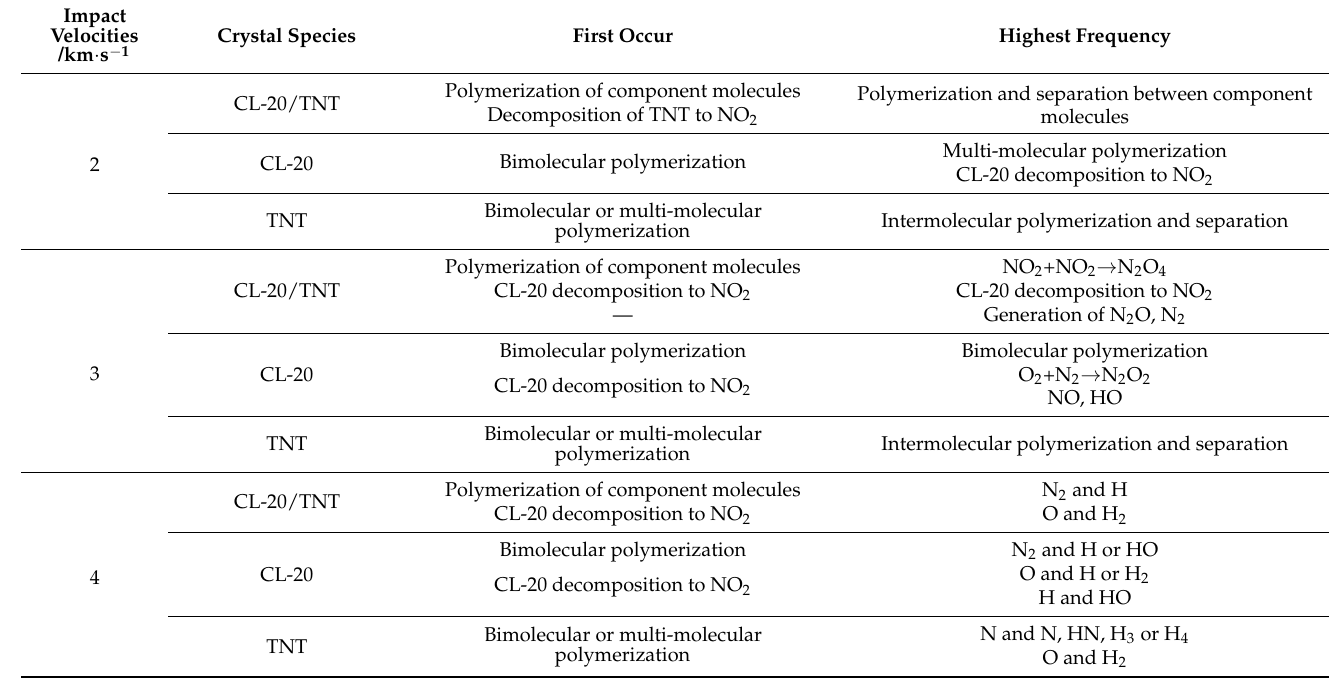
Table 5. Earliest and high-frequency chemical reactions in the CL-20/TNT, CL-20 and TNT crystals at different impact